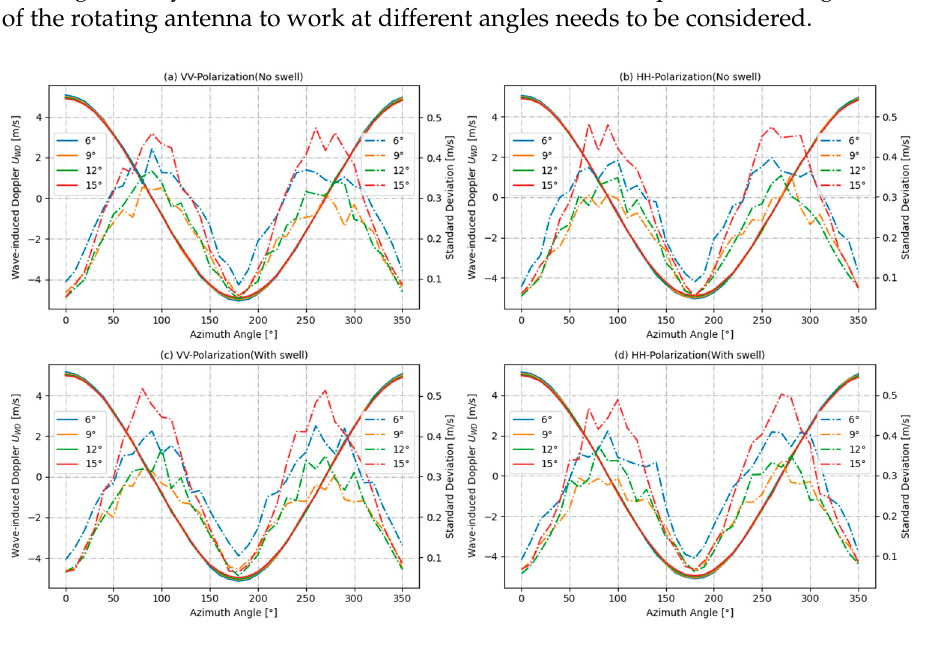
Figure 9. Variation in U WD values and standard deviations with azimuth for incidence angles of 6°, 9°, 12°, and 15°, wind direction of 0°, and wind speed of 10 m/s. There is no swell in ( a , b ), and there is a swell in ( c , d ) with a wavelength of 150 m, a wave height of 1 m, and a direction of 0°. The y-axis on the left refers to U WD values, which are shown in colored solid lines. The y-axis on the right refers to U WD standard deviations, which are shown in colored dashed lines.